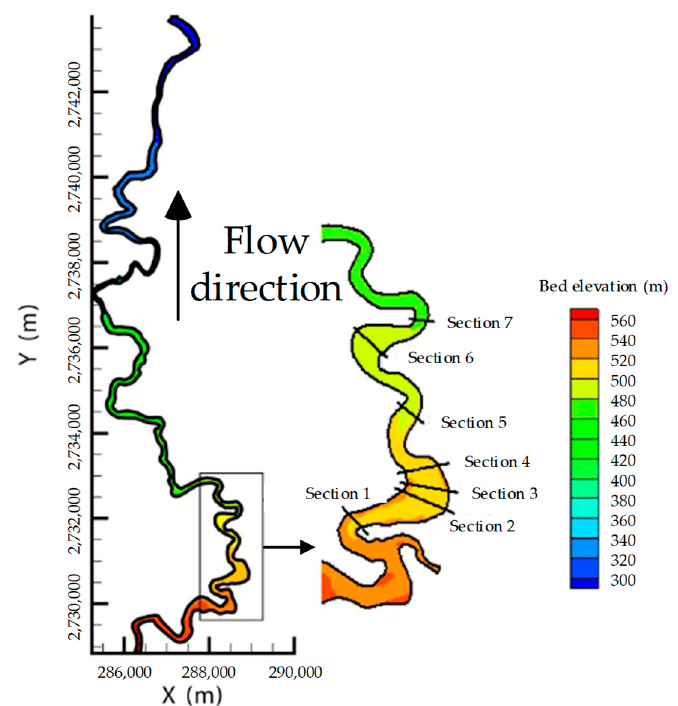
Figure 4. The bathymetry and seven cross-sections used to compare with the measurements for the Sedimentation and River Hydraulics-Two-Dimensional River Flow Modeling (SRH-2D) model. The coordinate is based upon the TWD97/TM2 system.